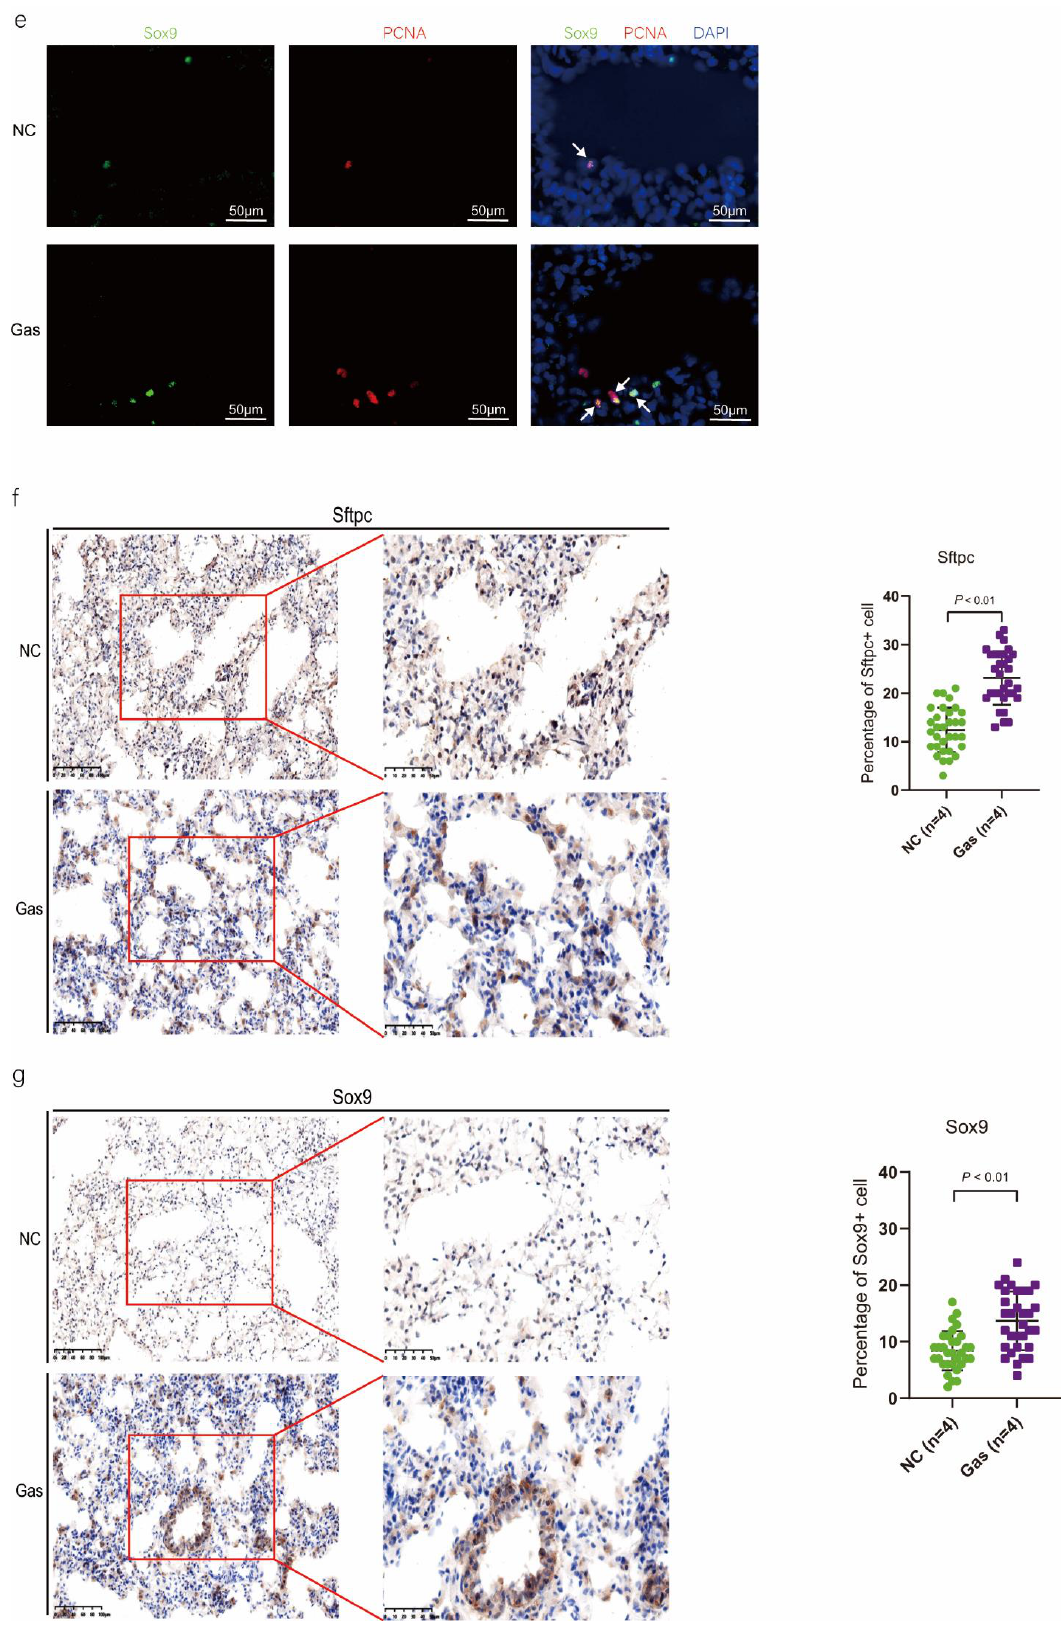
Figure 3. SOX9 expression is upregulated in lung AECs. ( a ) qPCR analysis of Sftpc and Sox9 transcripts at different stages of lung development. ( b ) Lung sections of NC and Gas group rats stained for